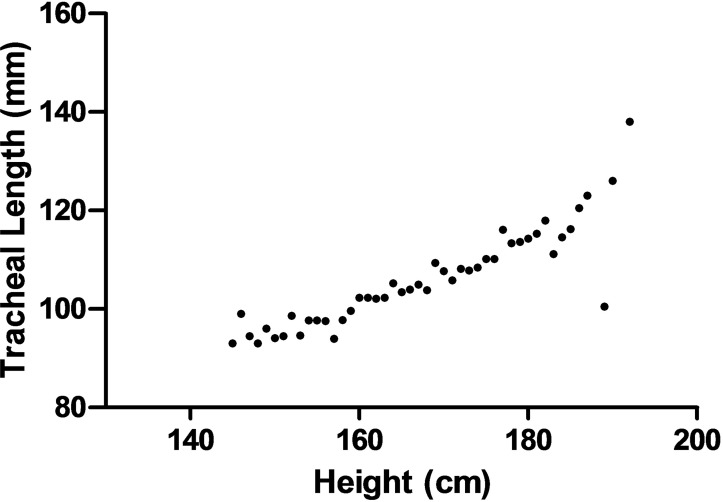
The scatterplot of the average TL (Tracheal length) and Height.(A) Male, (B) Female.